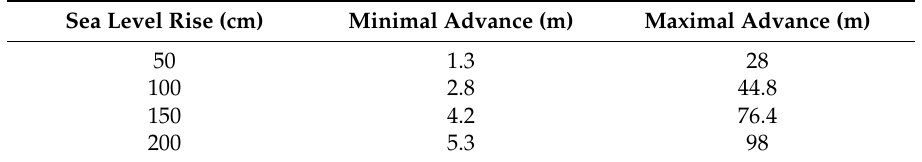
Table 1. Advancement inland of the seawater/freshwater interface (m) with respect to sea level rise. Sea Level Rise (cm) Minimal Advance (m) Maximal Advance (m) 50